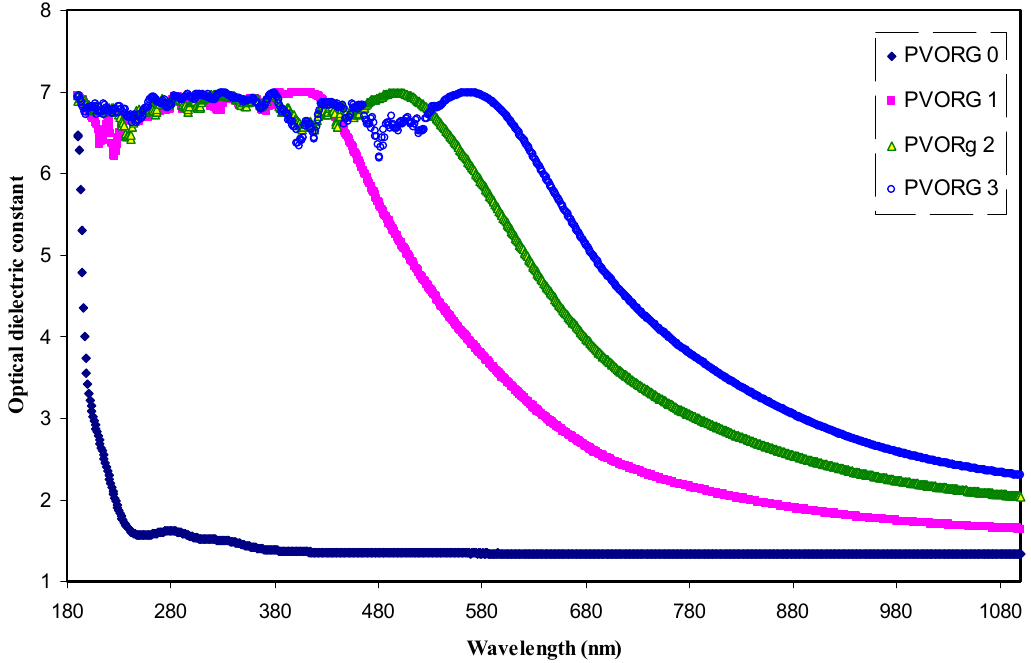
Figure 10. Dielectric constant spectra versus wavelength for pure PVA (PVORG0) and PVA composite films.